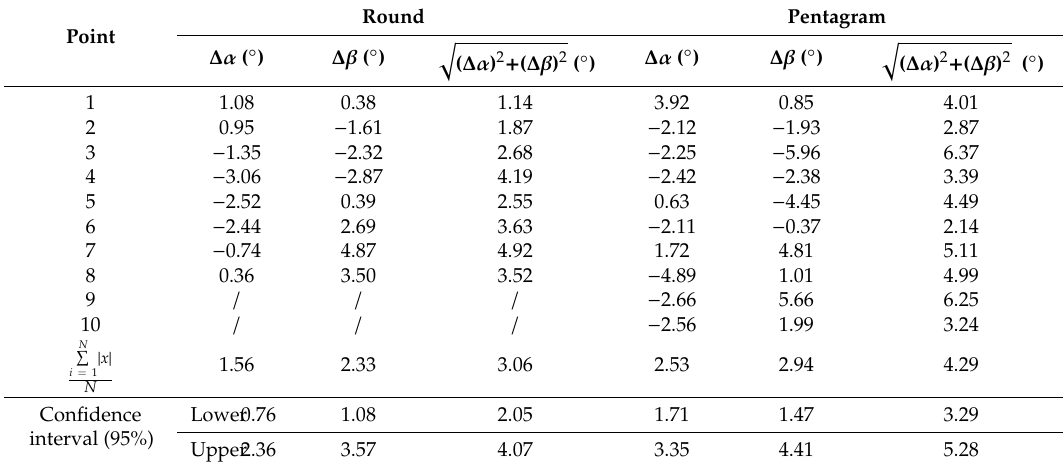
Table 2. The resolved absolute error of wrist motion-dependent angle coordinate ( α , β